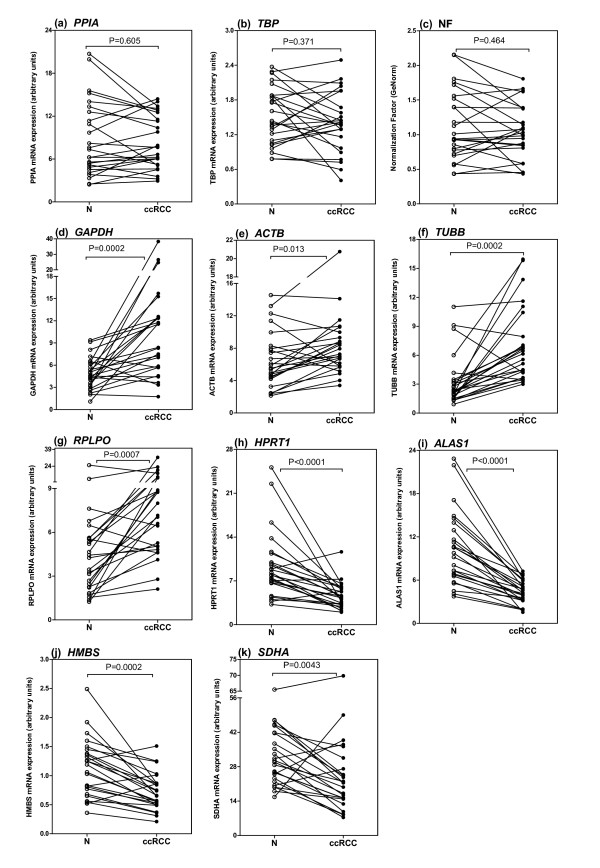
Differential mRNA expression of candidate reference genes in matched non-malignant (N; blank circles) and malignant renal cell carcinoma (ccRCC; black circles) tissue samples shown as connected lines. (a-c). Gene expression of non-regulated reference genes PPIA and TBP. The Normalization Factor was calculated from both non-regulated genes with the program geNorm (see text). (d-g). Gene expression of up-regulated candidate reference genes GAPDH, ACTB, TUBB, and RPLPO. (h-k). Gene expression of down-regulated candidate reference genes HPRT1, ALAS1, HMBS, and SDHA. Significances were calculated with the Wilcoxon test of paired samples.